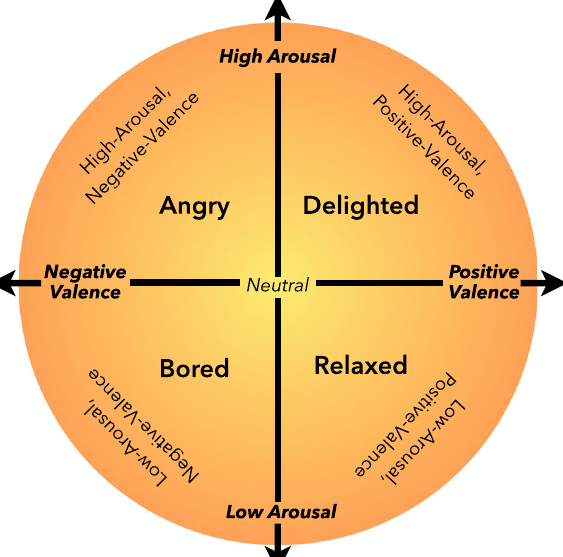
Figure 1. Arousal and valence emotion